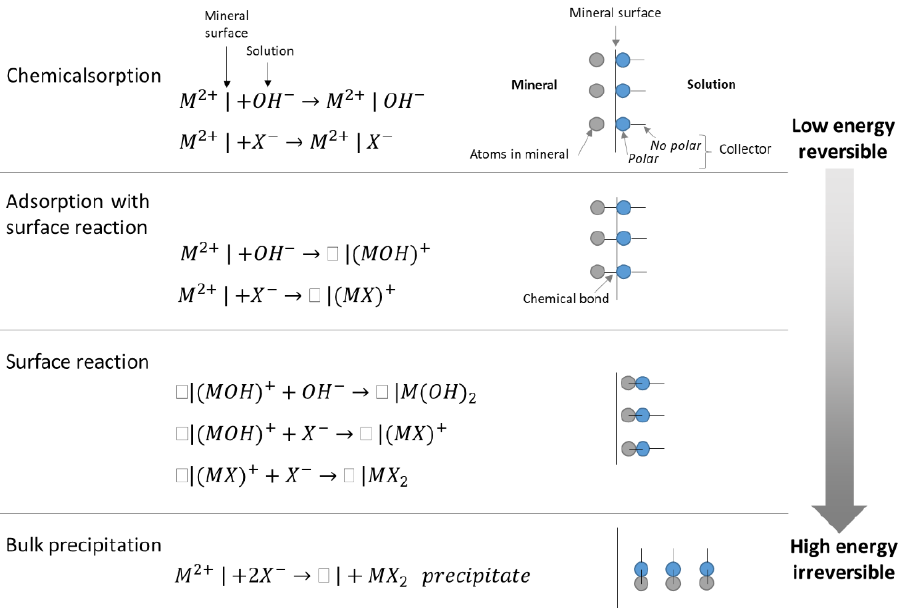
Figure 19. Mechanisms of interaction between the sulfide mineral surface and the collector. Both oxyhydric and sulfhydric ions interact with the mineral surface, competing for adsorption (adapted from Zanin et al. [79]).